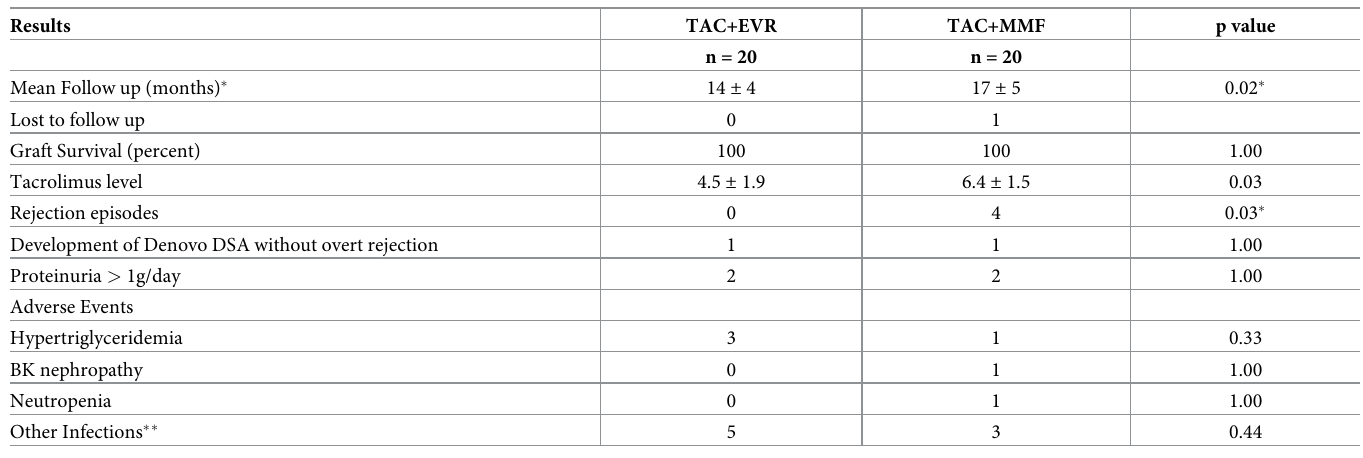
Table 2. Clinical results.